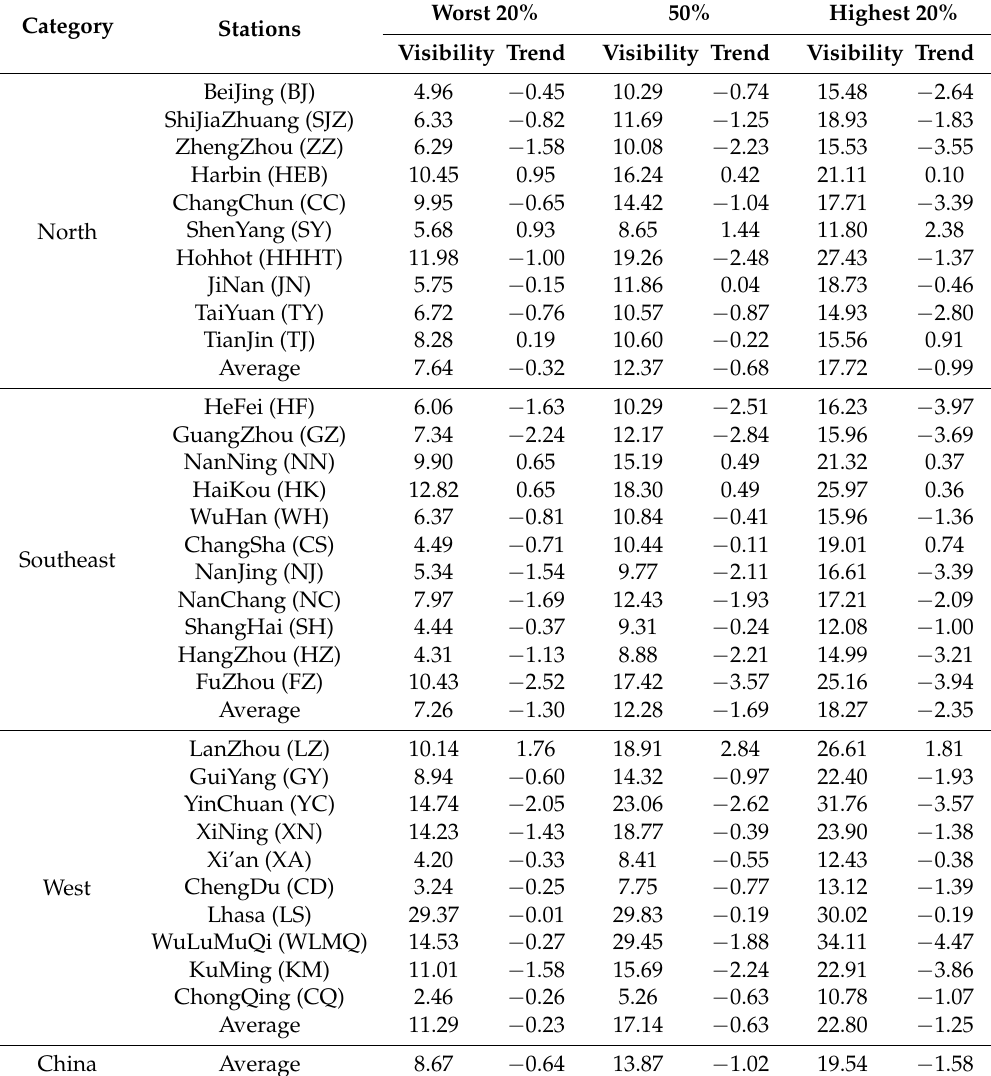
Table 3. Lowest 20% and 50%, and the highest 20% atmospheric visibility (km) as well as the changing trends (km/decade) of the PCCs in